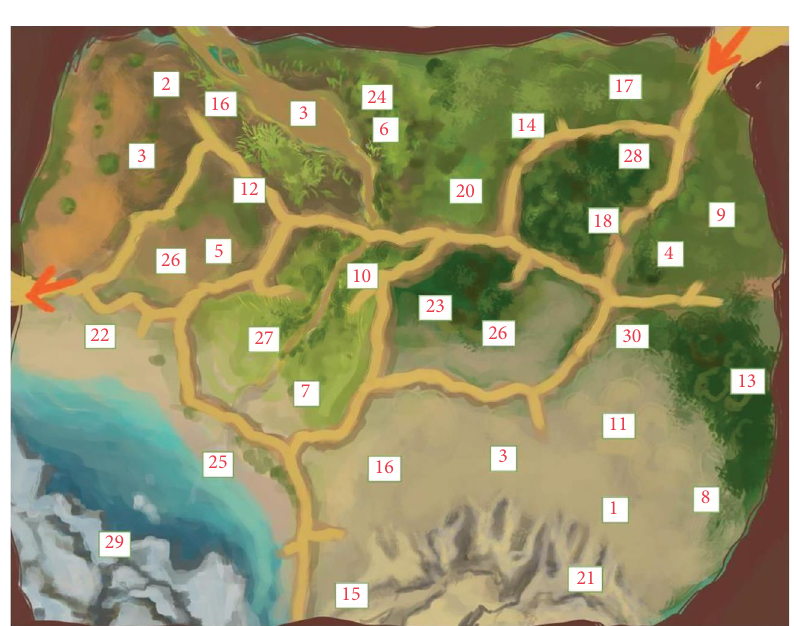
F IGURE 2: The landscape in the virtual environment. The number indicates the habitat of a particular animal.